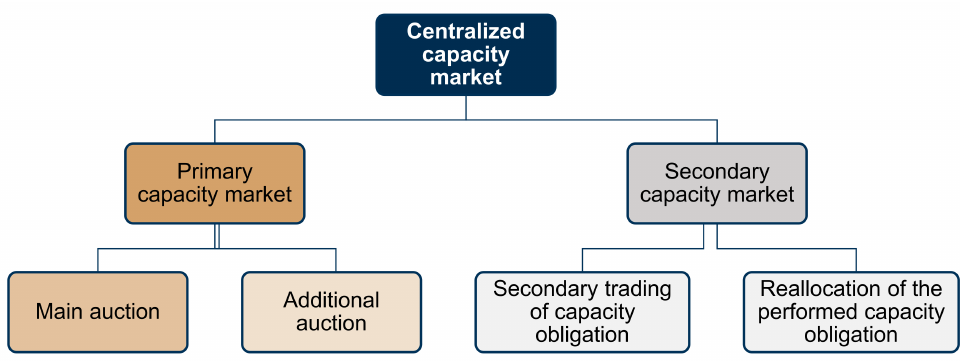
Figure 1. The general framework of the centralized capacity market implemented in Poland. Source: Own analysis based on [34].